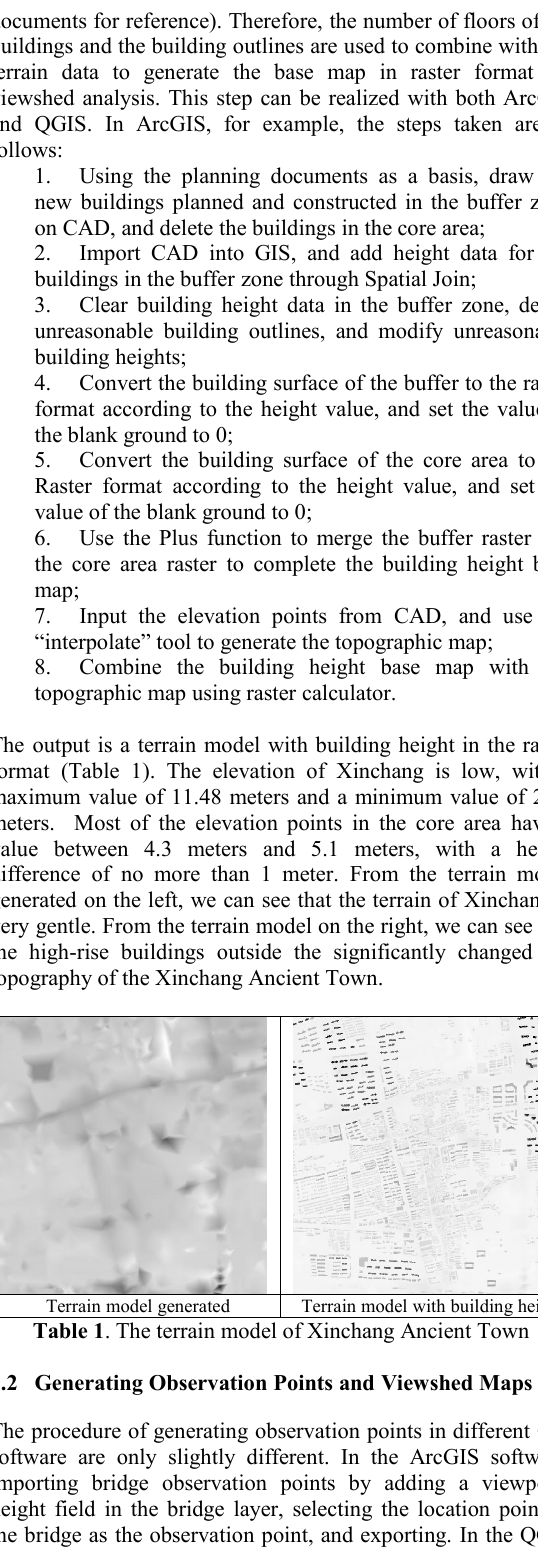
Figure 4 . Hongfu Bridge (Photo by Bowen